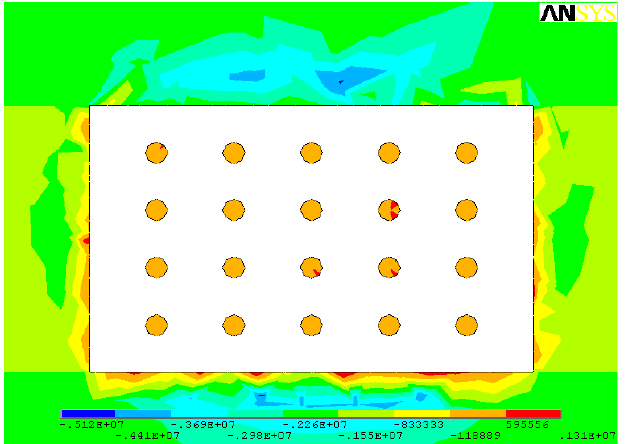
Figure 32. Maximum principal stress distribution in the middle of the pillar at 1480 mL of scheme 7 (parameters of scheme 7: stope height 4.5 m, pillar diameter 2 m, pillar spacing 6 m, pillar row spacing 7 m).